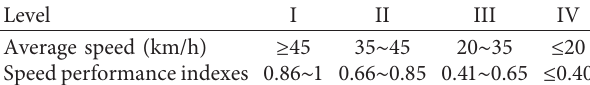
Table 2: Evaluation indexes of road congestion level. Level